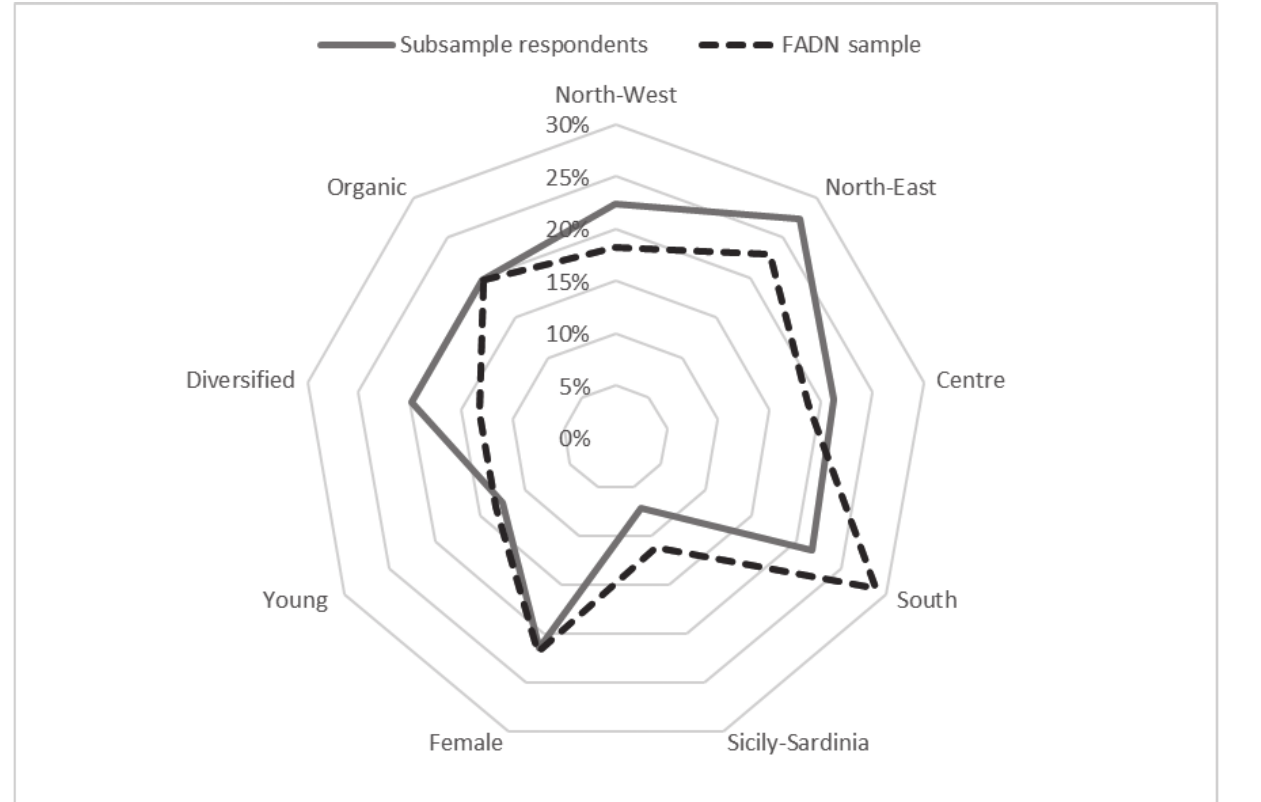
Figure 1. Comparison of FADN sample and subsample of respondents. Source: own elaboration on FADN and collected